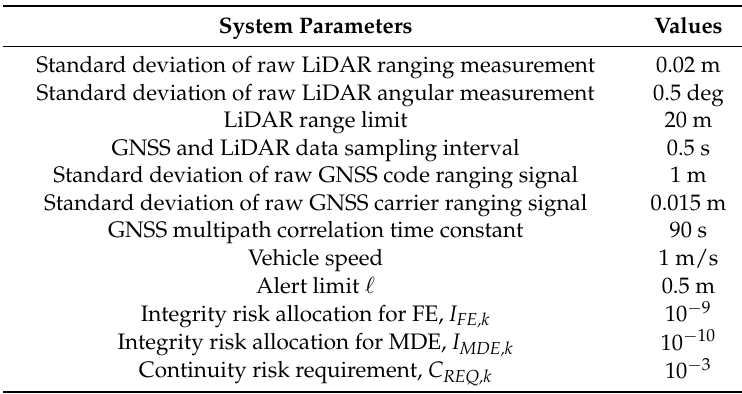
Table 1. Simulation